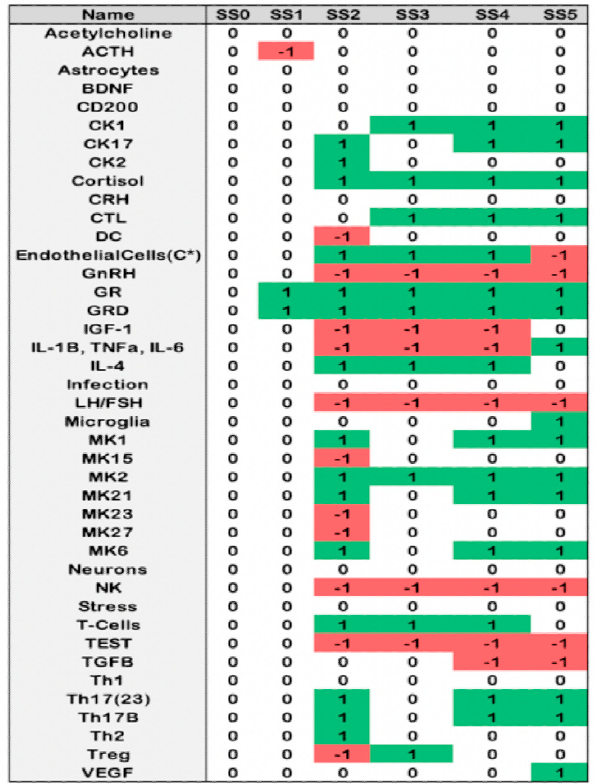
Figure 4. Predicted stable states of the theoretical male neuroimmune signaling network presented in Figure 3. White fill indicates a nominal state the same as the healthy control (0); green a state higher than the healthy control (1); and red state lower than healthy control (-1).